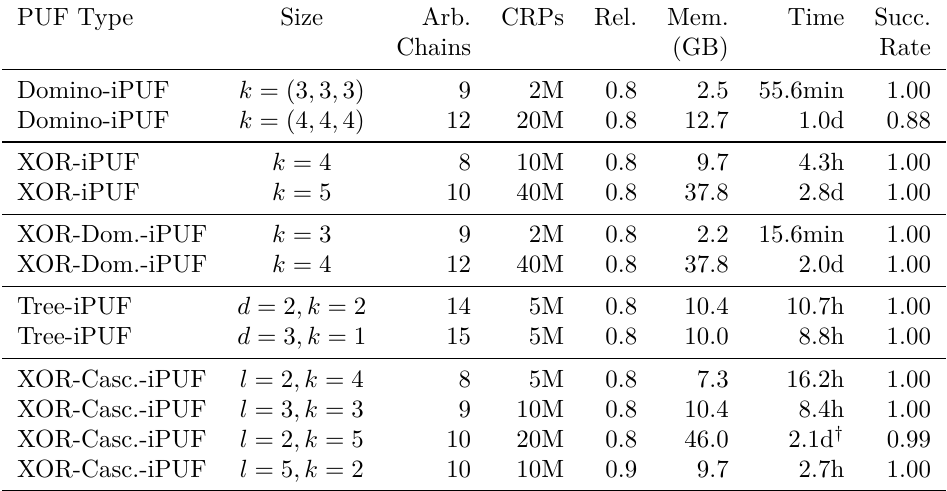
Table 2: Overview over Deep-Learning-Attacks on derivatives of the Interpose PUF design. Each derivative has been tested for a selection of different parameters with the challenge- length fixed to 64 bit. For each type and parameter, 100 simulations and attacks were conducted (experiments marked with † have at least 75 samples). Success was defined as prediction accuracy above 90%, relative to the PUF’s reliability. Note that attack times are all below comparable times for modeling the original Interpose PUF of similar sizes, even though a generic, non-specialized attack methodology was